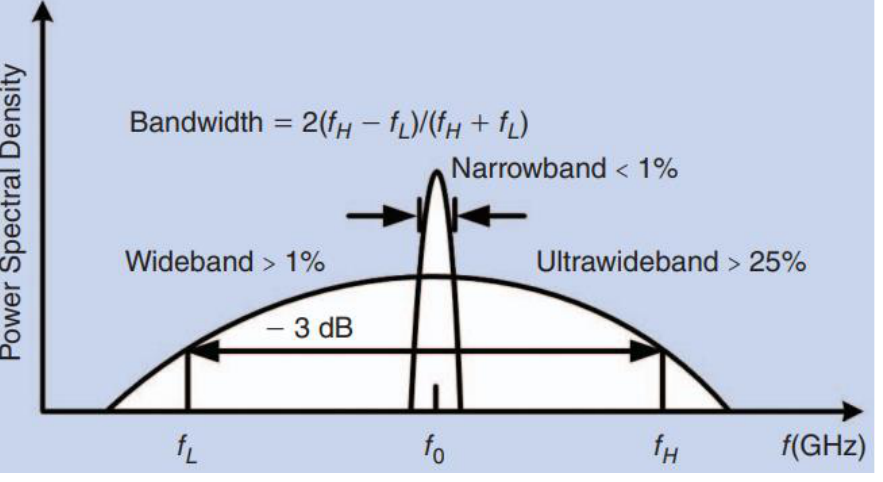
Figure 1. f L , f o , f H frequencies of UWB spectrum [1].